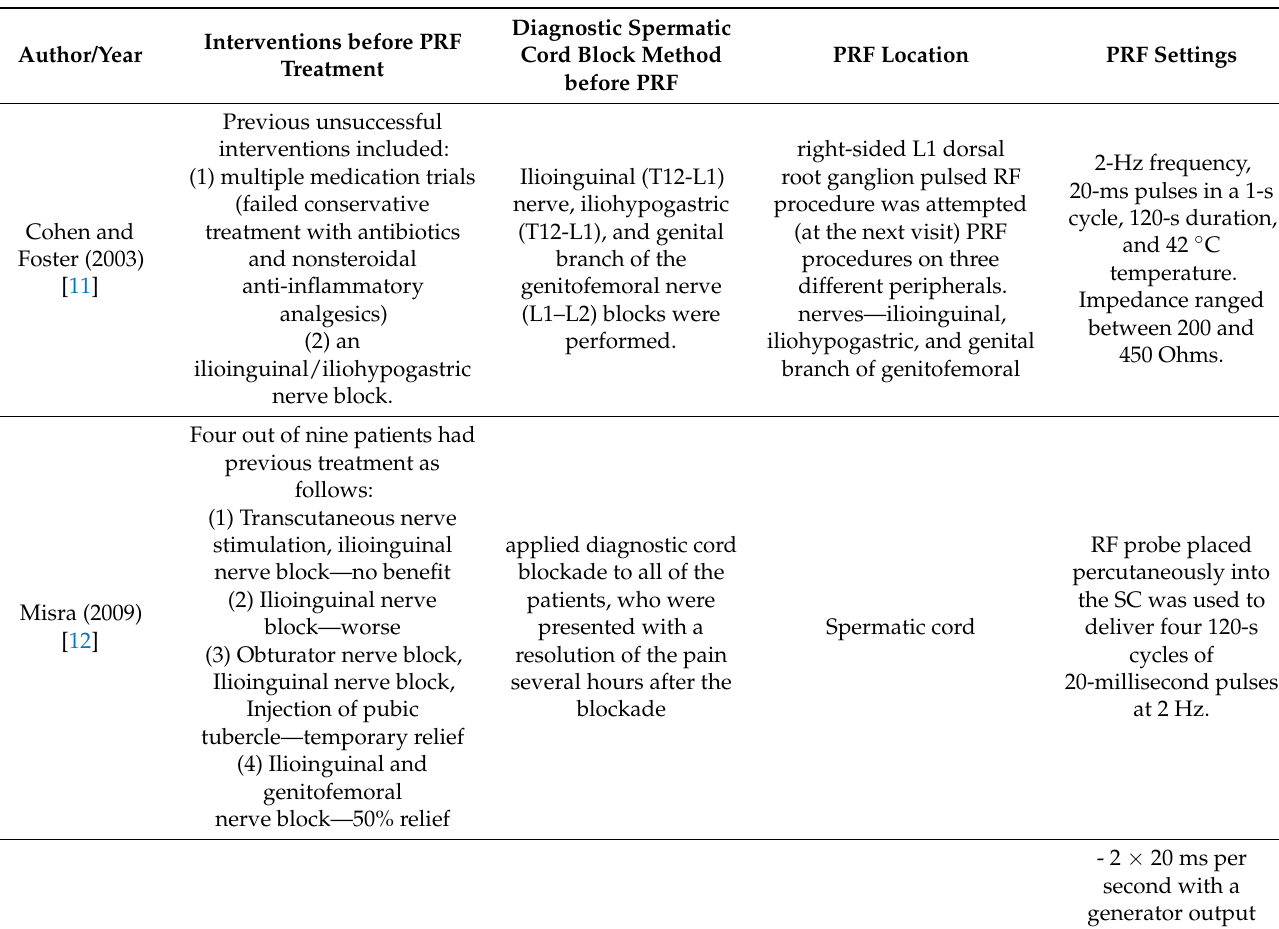
Table 3. Parameters setting of pulsed radio-frequency therapy for